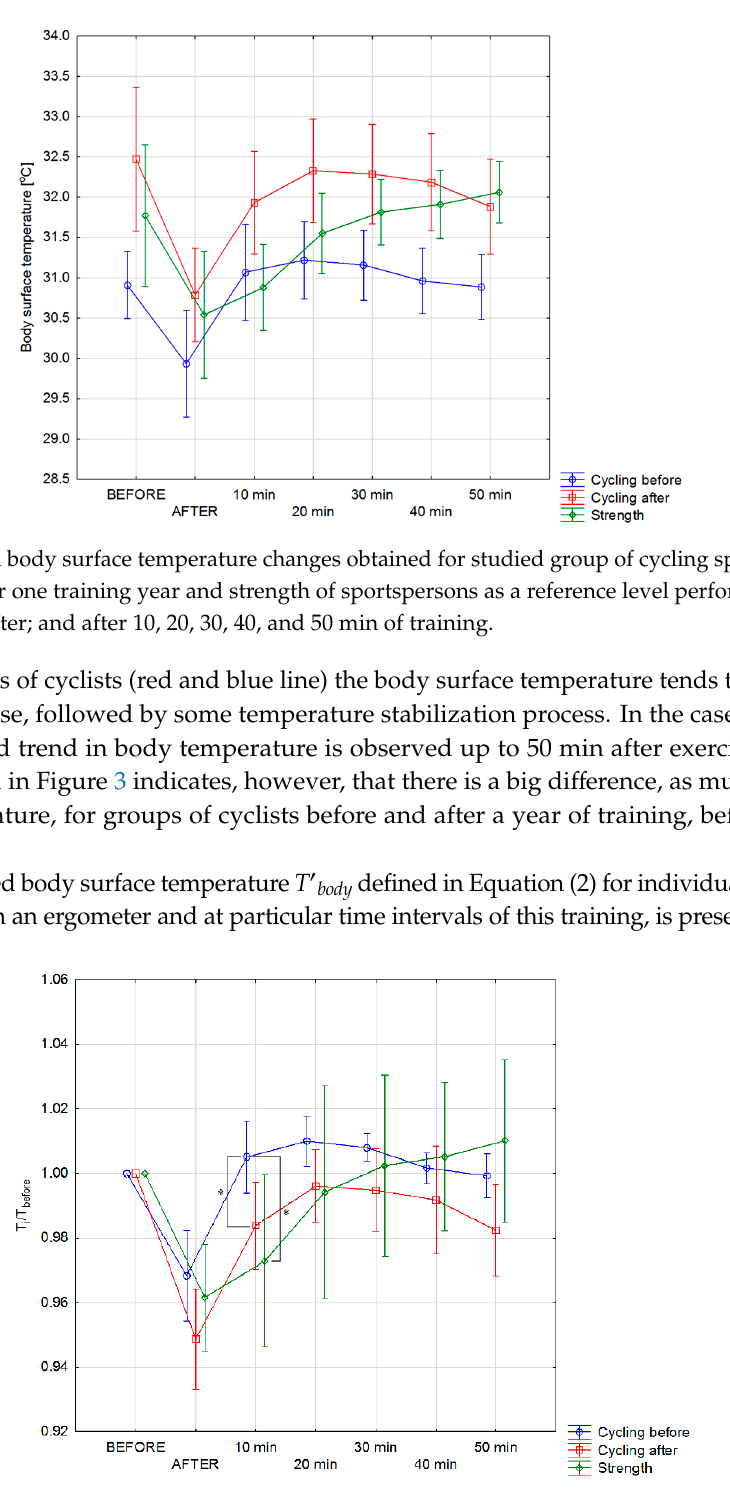
Figure 4. Normalized mean body surface temperature changes for studied group of cycling sportspersons before and after one training year and strength of sportspersons as a reference level performed before; immediately after; and after 10, 20, 30, 40, and 50 min of training. Statistically significant changes were marked as * on the graph with p < 0.05.